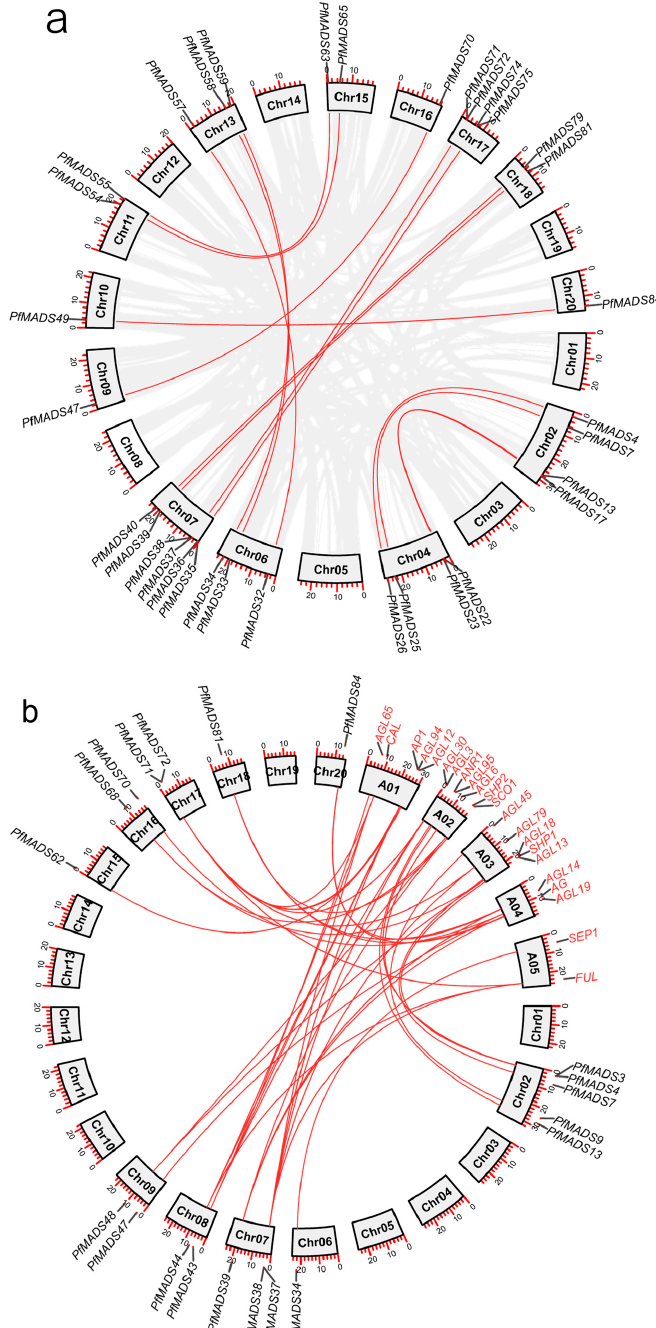
Figure 3. Synteny analysis of MADS-box genes in P. fortunei . ( a ) The duplication relationship of PfMADS-box genes. Gray lines represent all synteny blocks in the P. fortunei genome, red lines indicate the duplicated PfMADS-box gene pairs. ( b ) homologous analysis of MADS-box genes between P. fortunei and A. thaliana .